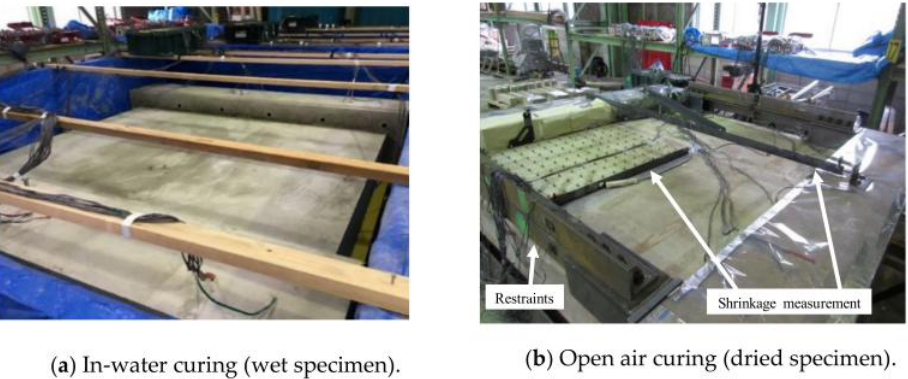
Figure 4. Curing conditions. ( a ) In-water curing (wet specimen), ( b ) open air curing (dried specimen).